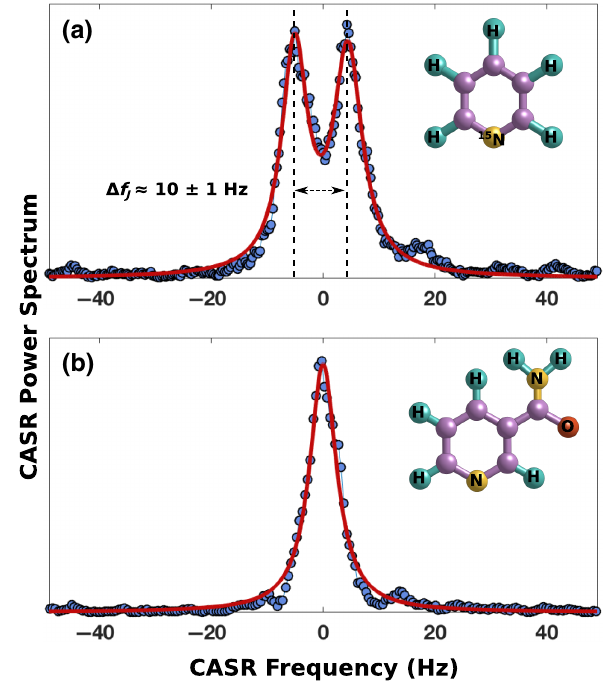
FIG. 4. SABRE-enhanced molecular NV-NMR spectra. (a) Single-shot CASR spectrum of hyperpolarized 15 N-labeled pyri- dine (blue circles) for a sensing duration of 3 s at a concentration of 100 mM. The double Lorentzian fit (solid red line) indicates a splitting of (cid:6) f J ≈ 10 ( 1 ) Hz (indicated by the vertical dashed lines) due to J coupling between the 15 N nucleus and the